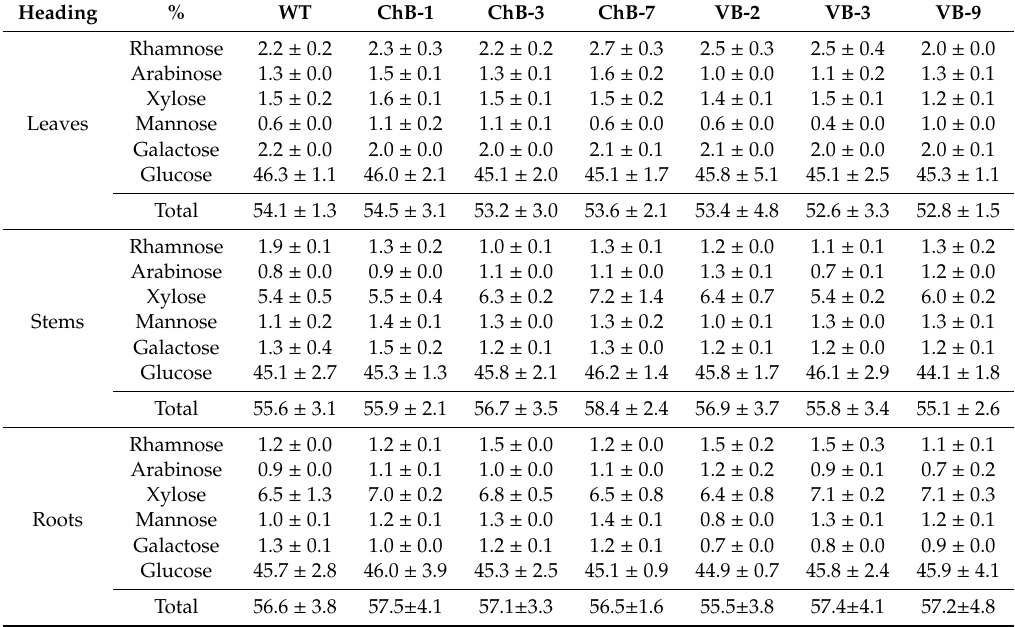
Table 1. Carbohydrate content of plant organs obtained from wild-type and transgenic tobacco plants overexpressing T. maritima BglB targeting the chloroplasts and